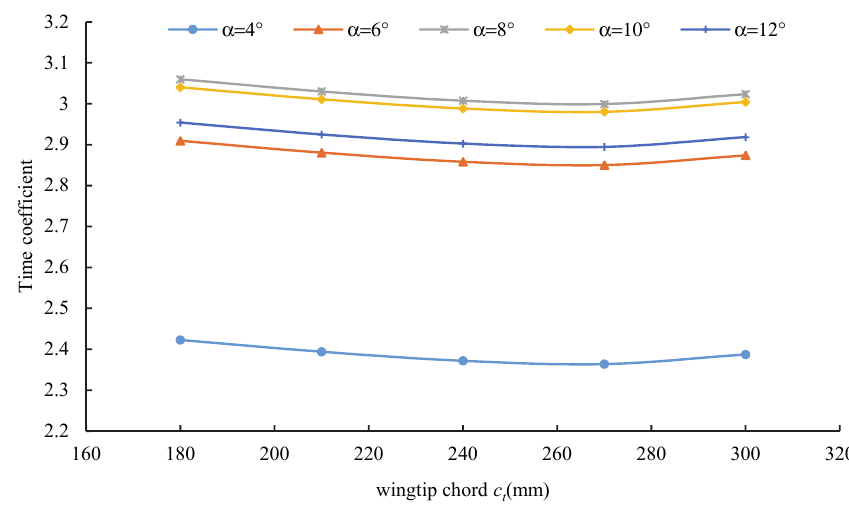
Figure 12. Relationship between the wingtip chord length c t and time coefficient.